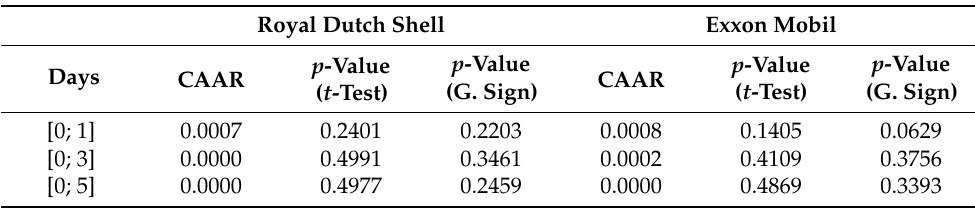
Table 4. Cumulative average abnormal returns Royal Dutch Shell and Exxon Mobil—Induced seismicity in Slochteren ( df = 422).